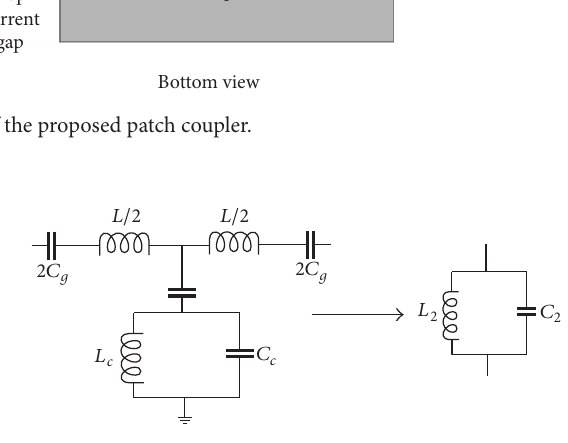
Figure 2: Equivalent circuit of CTSRR and its simplified